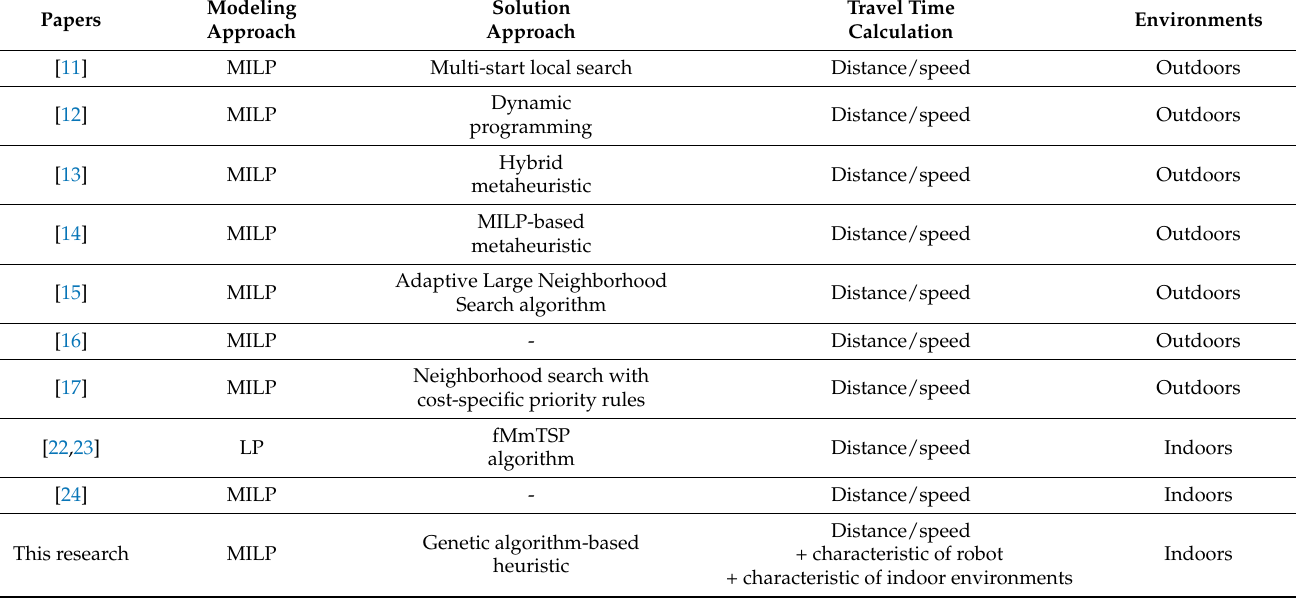
Table 1. Recent research on robot-based delivery